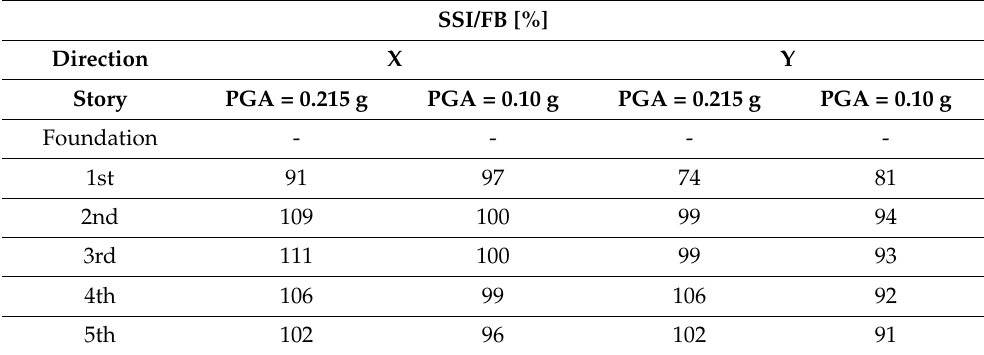
Table 12. Comparison of inter-story drifts.